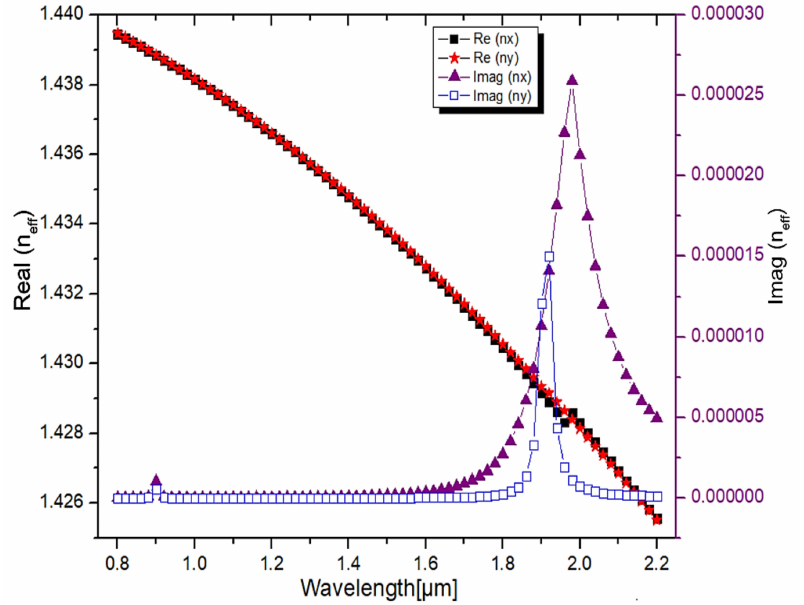
Figure 9. Real and imaginary parts of the PCF filter core guided mode as a function of